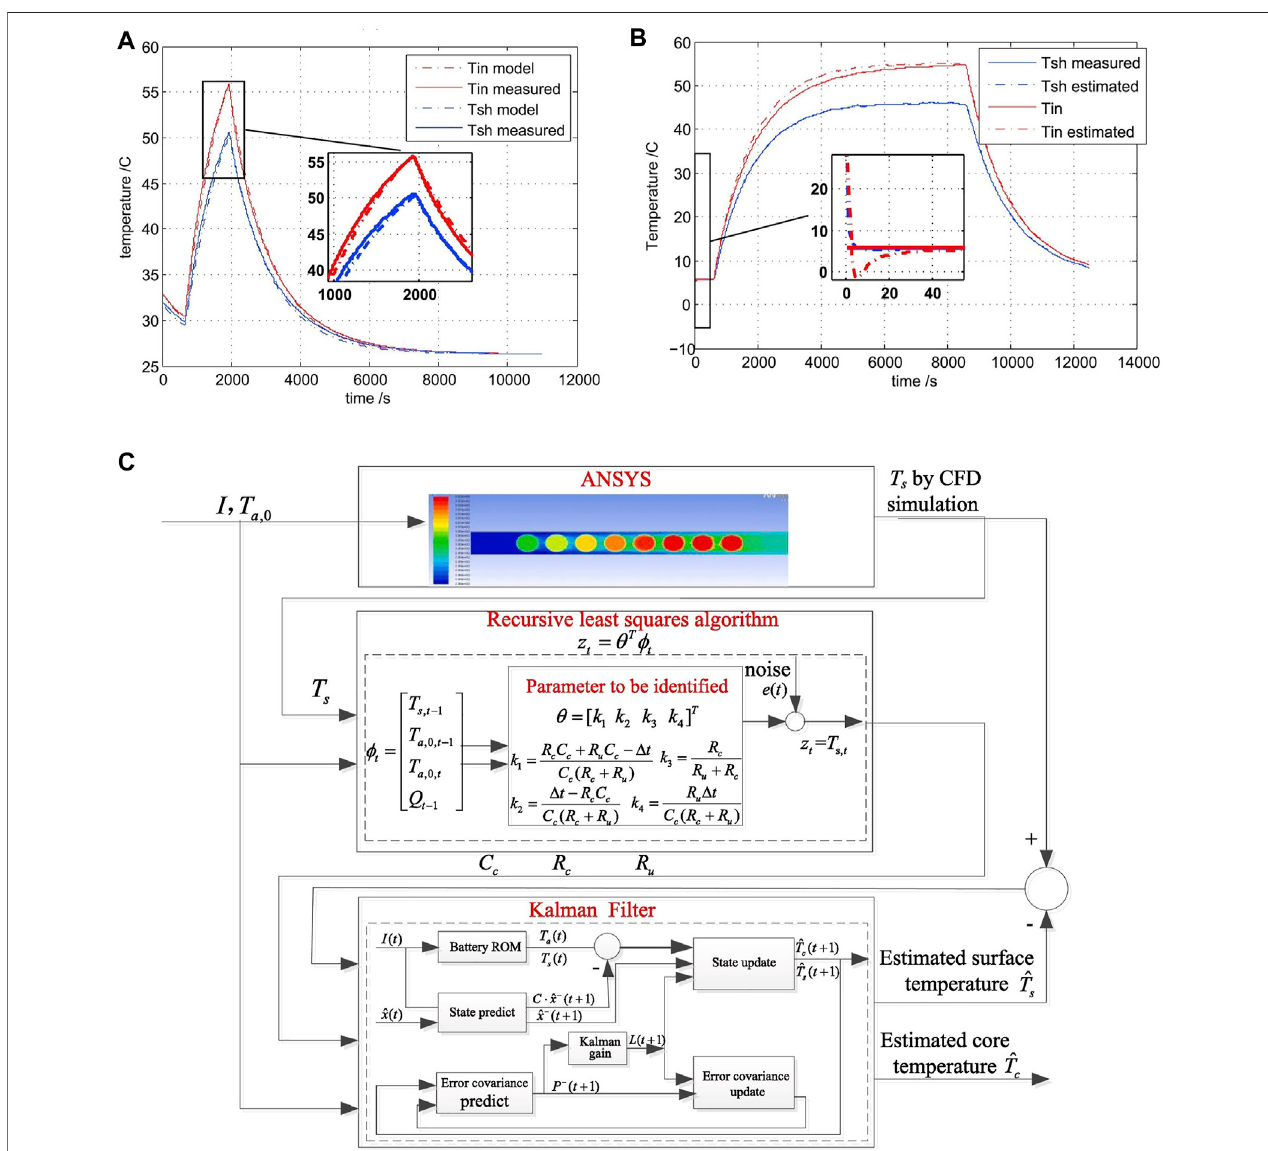
FIGURE 7 | (A) Model results (EKF) at an ambient temperature of 26.3 ° C (Zhang et al., 2016; Panel 7B, p. 151) and (B) EKF estimation results at an ambient temperature of 5.5 ° C (Zhang et al., 2016; Panel 8A, p. 153). T in : internal temperature, T sh : surface temperature. (C) Structure of the parameter identi fi cation and temperature estimationmethod(Maetal.,2020;Panel 14,p.6).Reprintedfrom(Zhanget al.,2016),Copyright(2016);reprintedfrom (Maetal.,2020),Copyright(2020) with permission from